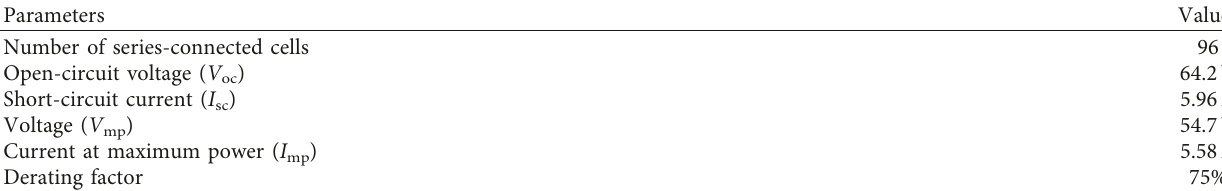
Figure 2: PV parameters behavior: (a) IV and (b) PV characteristics. Table 3: PV array specifications for one